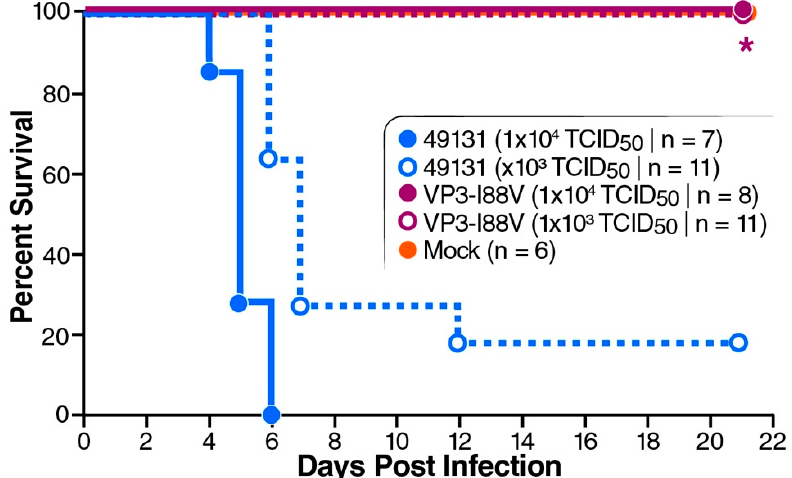
Figure 6. Neurovirulence test for 49131-VP3-I88V mutant. Five-day-old mice were i.c. inoculated with